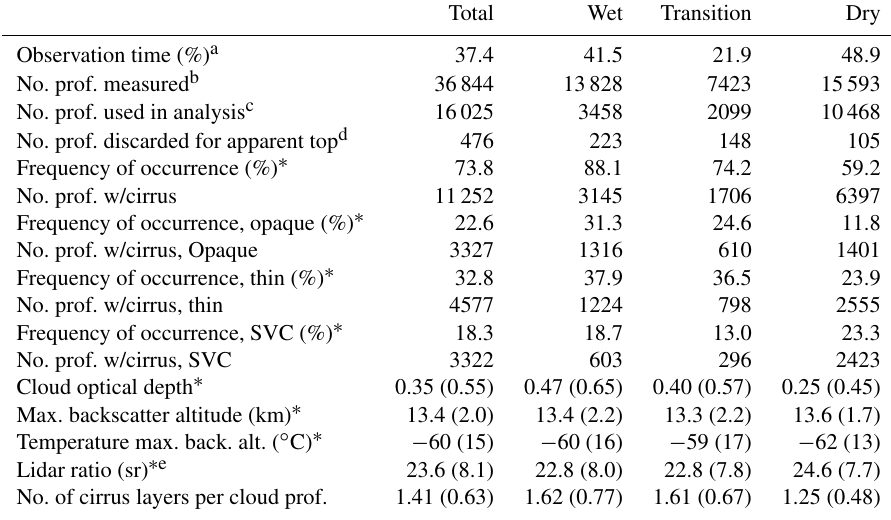
Table 2. Summary of column-integrated statistics for the total time of observation, as well as for the wet, transition, and dry seasons. Frequency of occurrence is calculated using a conditional sampling to avoid biases (Sect. 2.4). Mean cirrus cloud properties and standard deviation of the sample (in parentheses) are shown. The standard deviations of the mean were calculated and used to determine if seasonal differences (wet–dry) of the mean values are statistically significant to the 95% confidence level (indicated as *) using a two-sample t test. Geometrical properties are not given because most cloud profiles have more than one layer of cirrus. Lidar ratio is calculated as a column